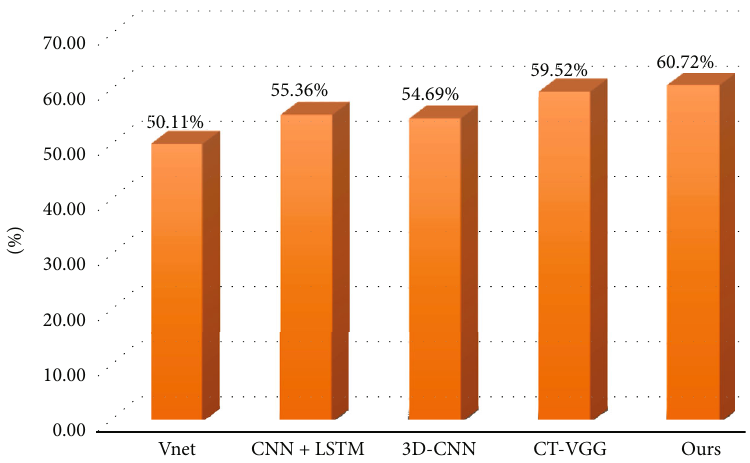
Figure 7: Comparison of recognition results of di ff erent network models applied to BAUM-1s dataset.